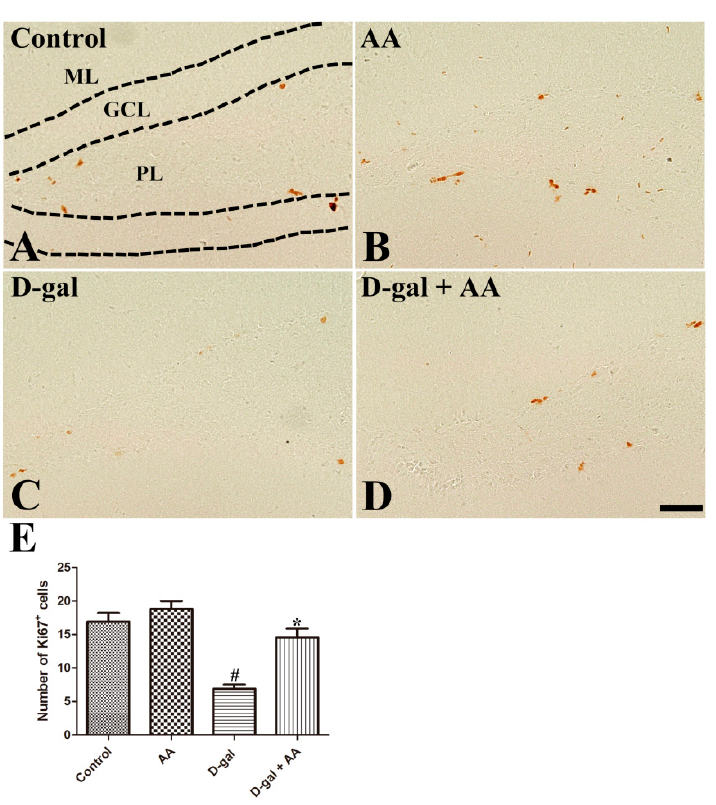
Figure 2. Immunohistochemistry for Ki67 in the dentate gyrus in control ( A ), ascorbic acid (AA) ( B ), D-galactose (D-gal) ( C ), and ascorbic acid (150 mg/kg)-fed D-gal ( D ) groups. Ki67-positive nuclei are observed in the subgranular zone of the dentate gyrus (arrows). Note that numbers of Ki67-positive nuclei significantly decrease in the D-gal group, and ascorbic acid treatment significantly increases cell proliferation in the D-gal + AA group. GCL, granule cell layer; ML, molecular layer; PL, polymorphic layer. Scale bar = 50 µ m. ( E ) The number of Ki67-positive nuclei in the subgranular zone of the dentate gyrus ( n = 10 per group; # p < 0.05, indicating a significant di ff erence between control and D-gal groups; * p < 0.05, indicating a significant di ff erence between D-gal and D-gal + AA groups). Data are presented as means ± SEM.